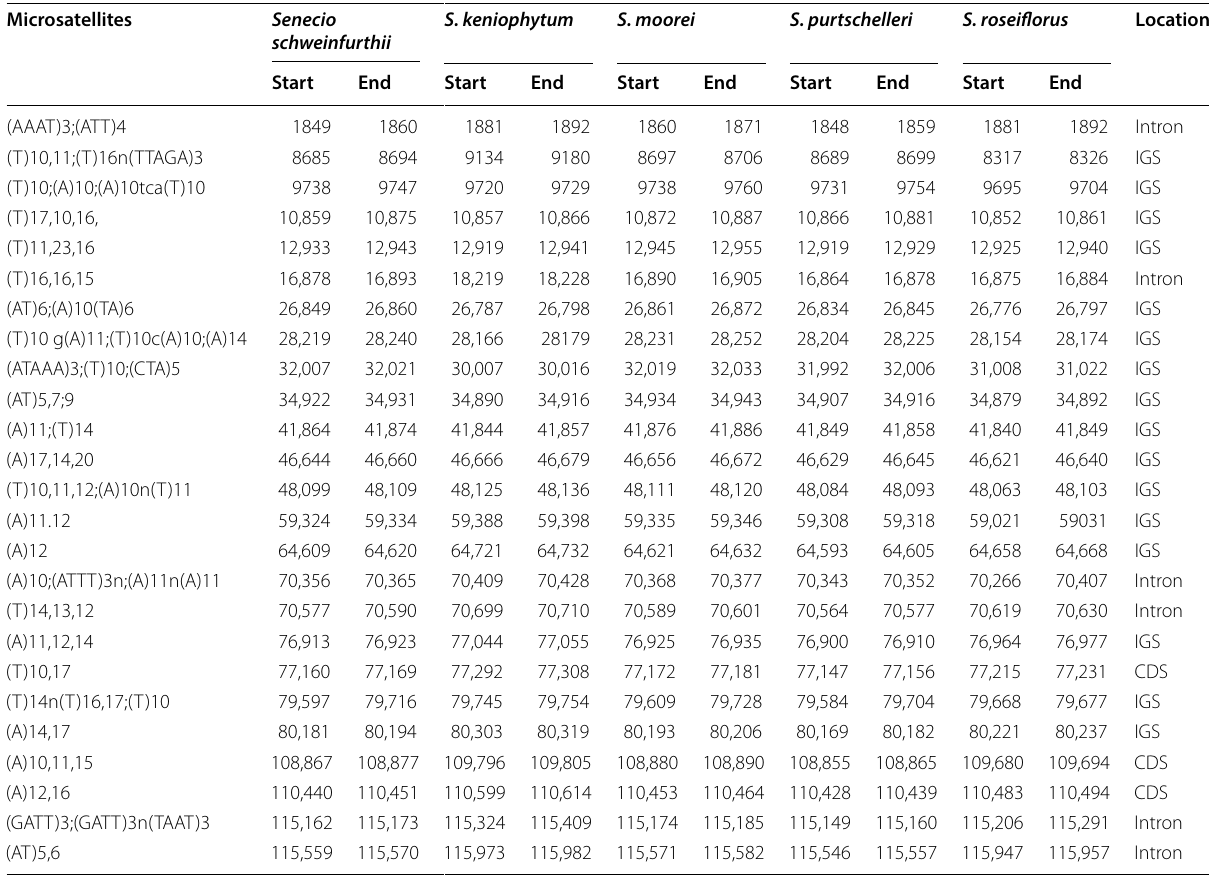
Table 3 Details of 25 potentially polymorphic microsatellite repeats in five species of Senecio Microsatellites